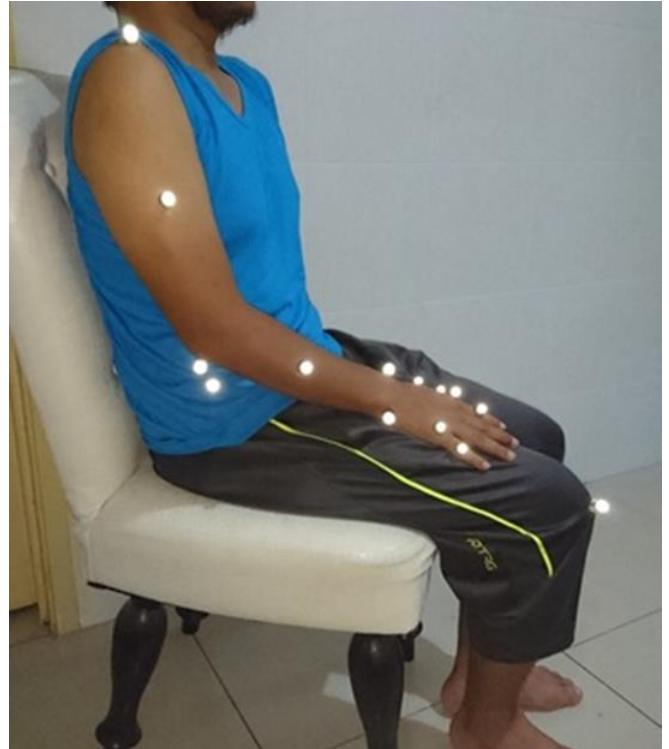
Figure 1. Original position.